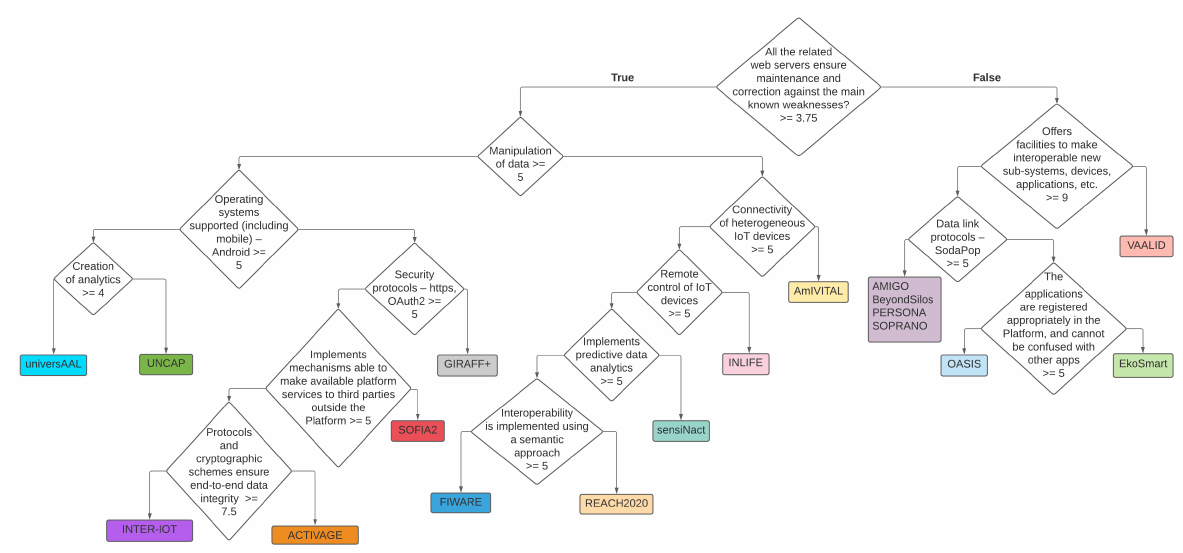
Figure A2. Taxonomy generated from standardized input